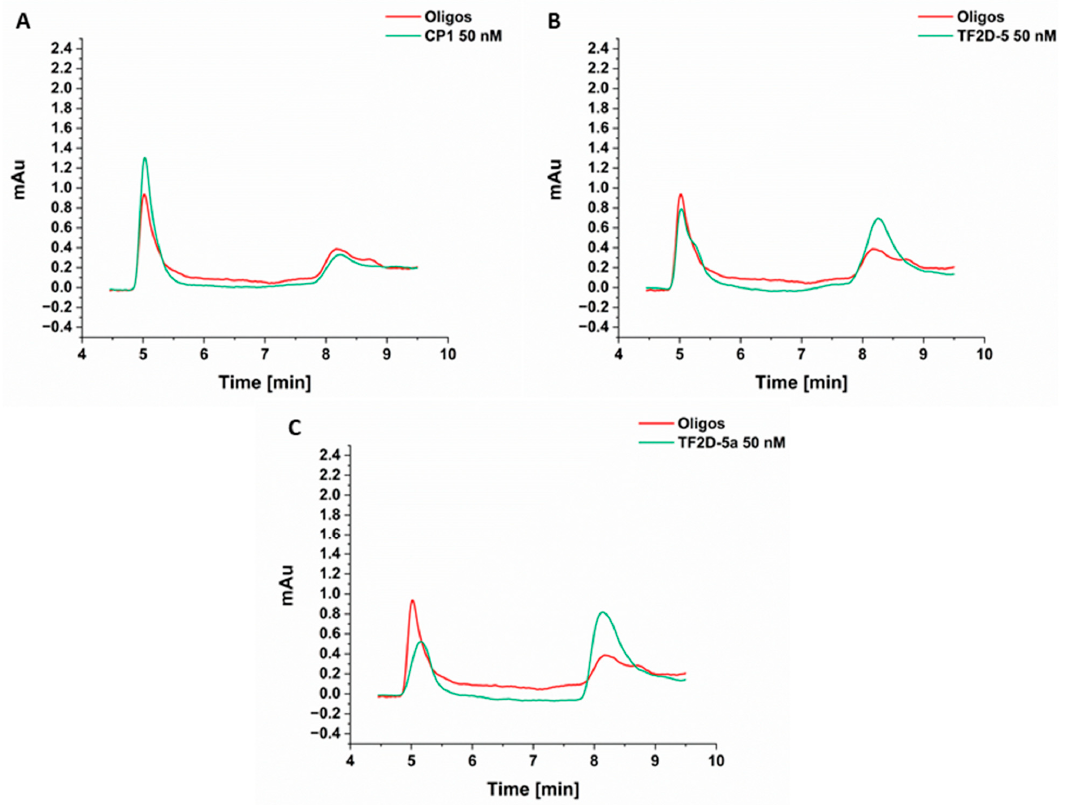
Figure 10. HPLC measurements after seeded aggregation of tau with soluble tau oligomers. Tau monomer with a concentration of 100 nM was incubated with 100 nM soluble tau oligomers and variable sub-stoichiometric concentrations of TF2D-5, TF2D-5a, and CP1. ( A ) CP1 was added at a concentration of 50 nM to the sample. No deviation from the reference sample was observed. ( B ) TF2D-5 was added at a concentration of 50 nM to the sample. We observed an increase in the retained tau monomer peak (8–8.5 min) with increasing concentrations of TF2D-5. ( C ) TF2D-5a was added at a concentration of 50 nM. We observed a stronger increase in the retained monomer peak than with TF2D-5. Additionally, we observed that the oligomer peak decreased in height.